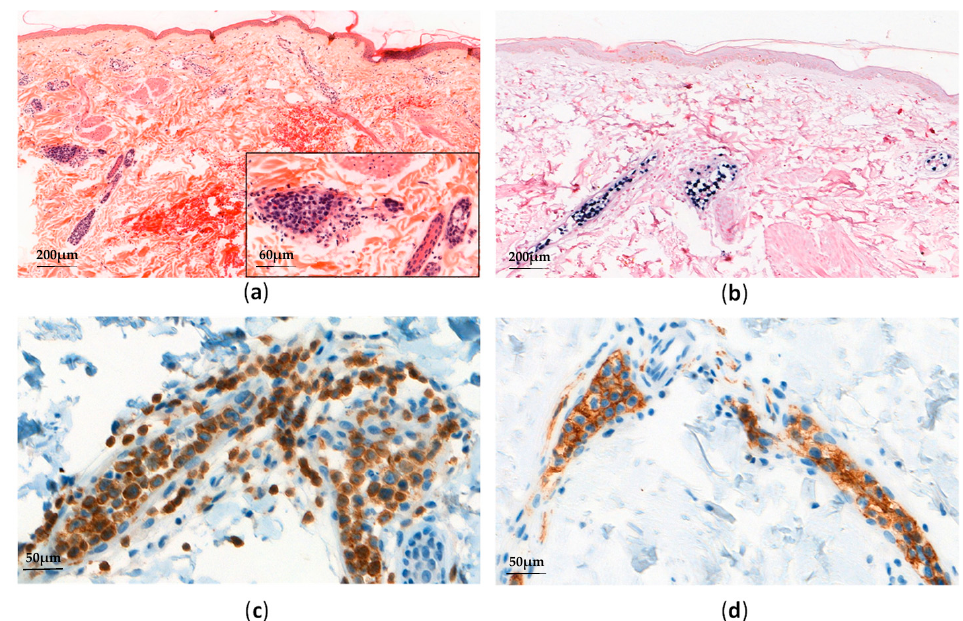
Figure 5. Aggressive NK-cell leukemia: ( a ) Skin biopsy shows an intravascular atypical lymphoid infiltrate (H&E, ×50 and ×200); ( b ) EBV-encoded small RNA (EBER) in situ hybridization is positive in almost all neoplastic lymphoid cells; ( c , d ) Neoplastic lymphoid cells are positive for CD3 ( c , ×300) and CD56 ( d , ×300).